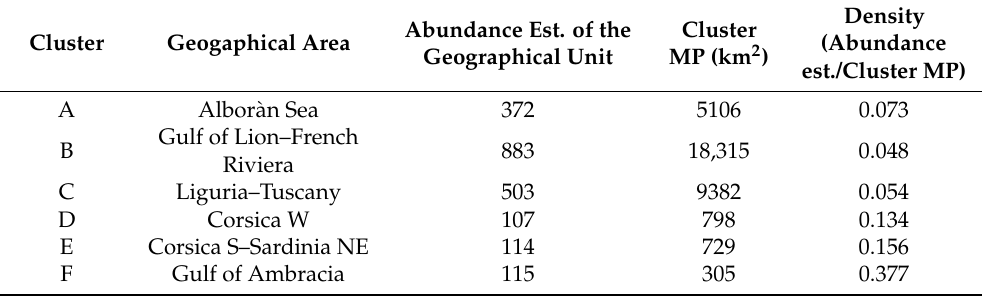
Table 8. The abundance estimates of each geographical unit are compared with the size of the relative MPs. The density is calculated as the ratio between these two values, being the MPs considered as an approximation of the area of occupancy of the same